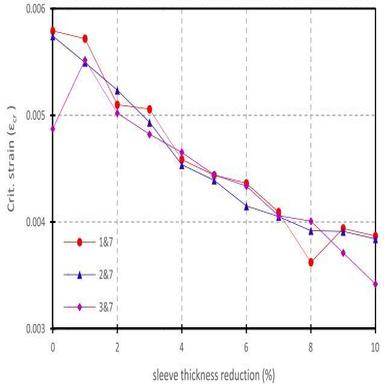
Plots of εcr for 50% scale (all imperfection types).